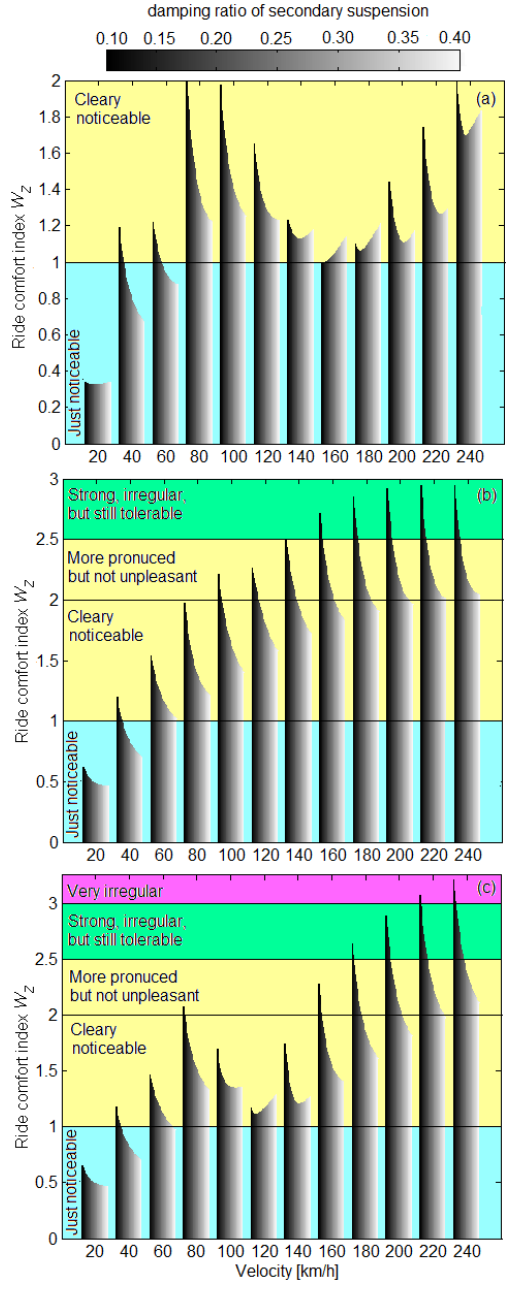
Figure 16. Ride comfort index W z depending on the damping ratio of secondary suspension: ( a ) in point C ; ( b ) in point B 1 ; ( c ) in point B 2 .